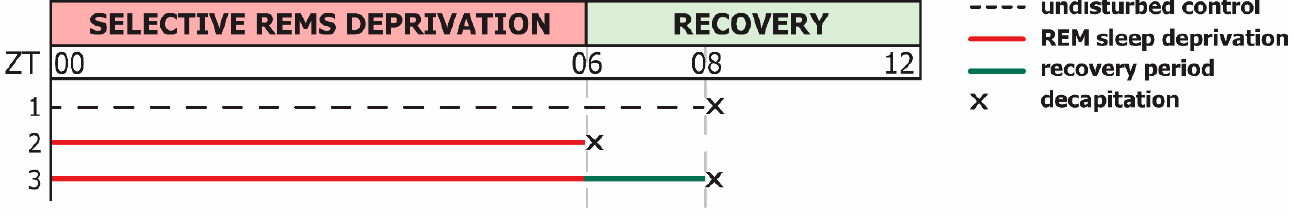
Figure 10. Experiment 2 scheme. Twenty-four-hour baseline recording was followed by 6 h selective REM sleep deprivation (REMSD, ZT00-06, lights on) and a 6 h recovery period (ZT06-12, lights on) for each animal. Three groups of rats were used ( n = 4 in each group) for Hspa1 expression analysis under REMSD conditions: (1) undisturbed control, ZT06; (2) REMS-deprived rats immediately after REMSD, ZT06; (3) REMS-deprived rats 2 h into the rebound period, ZT08.